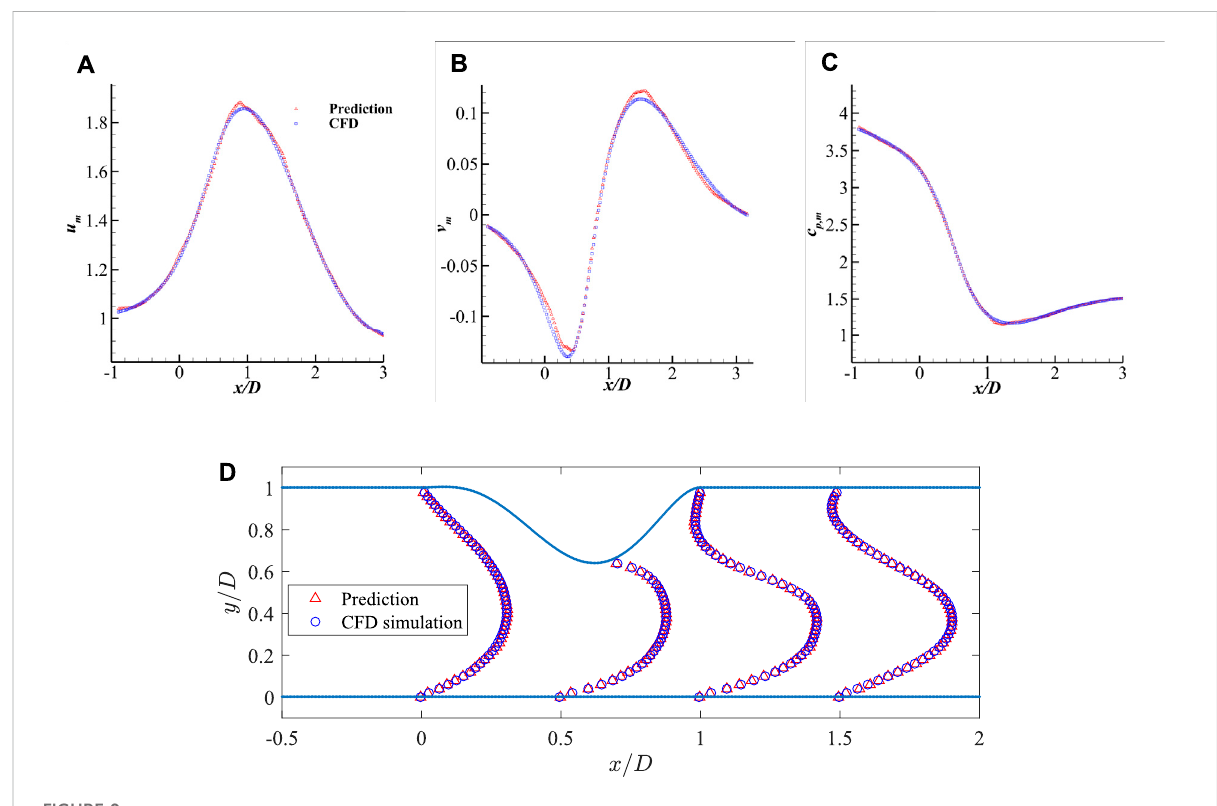
FIGURE 9 Comparison of the mean velocities and pressure along the streamwise direction measured at y = 0.2 D and the comparison of streamwise velocity pro fi le: (A) u m along x-axis, (B) v m along x-axis, (C) c p , m along x-axis, and (D) streamwise velocity pro fi le u m along y-axis.